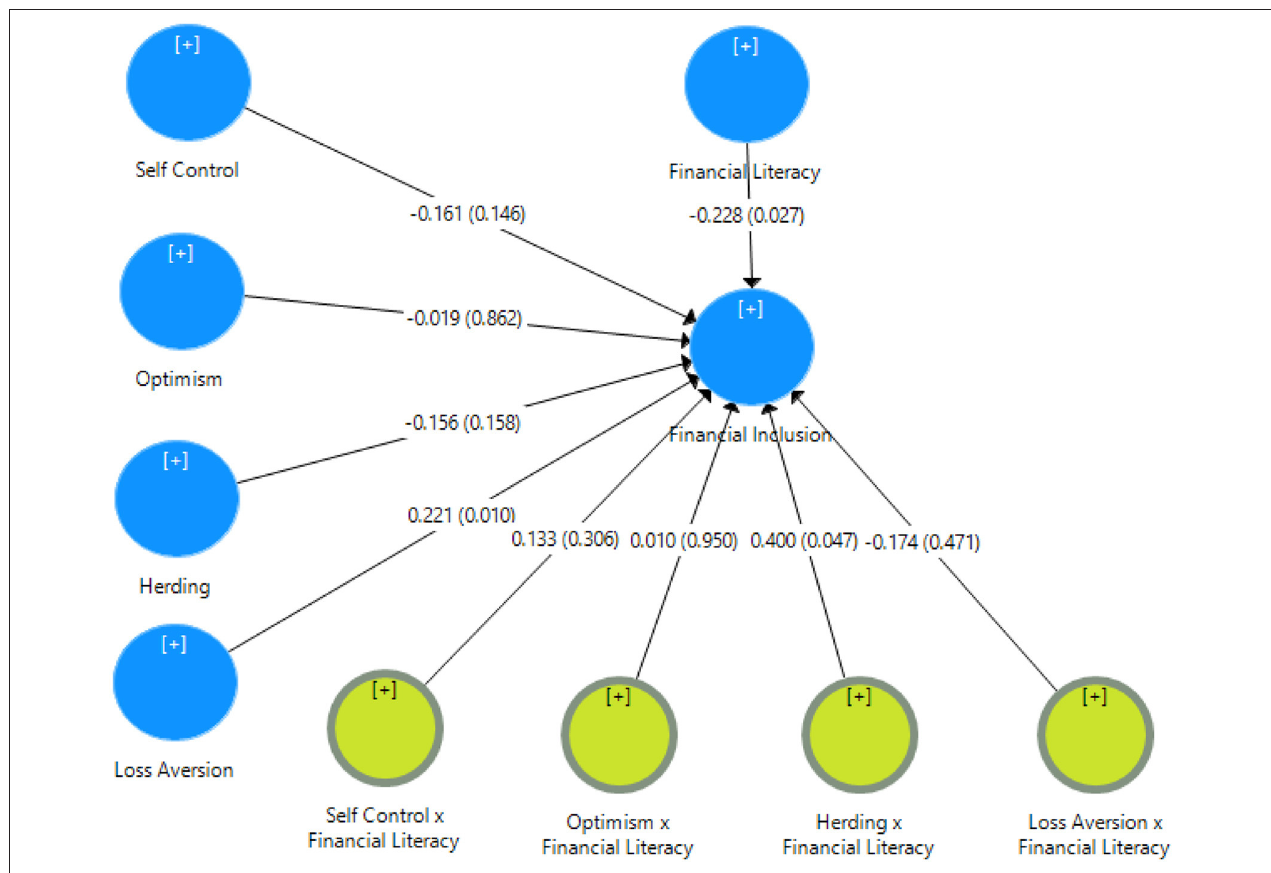
FIGURE 2 | Path coefficients in PLS-SEM